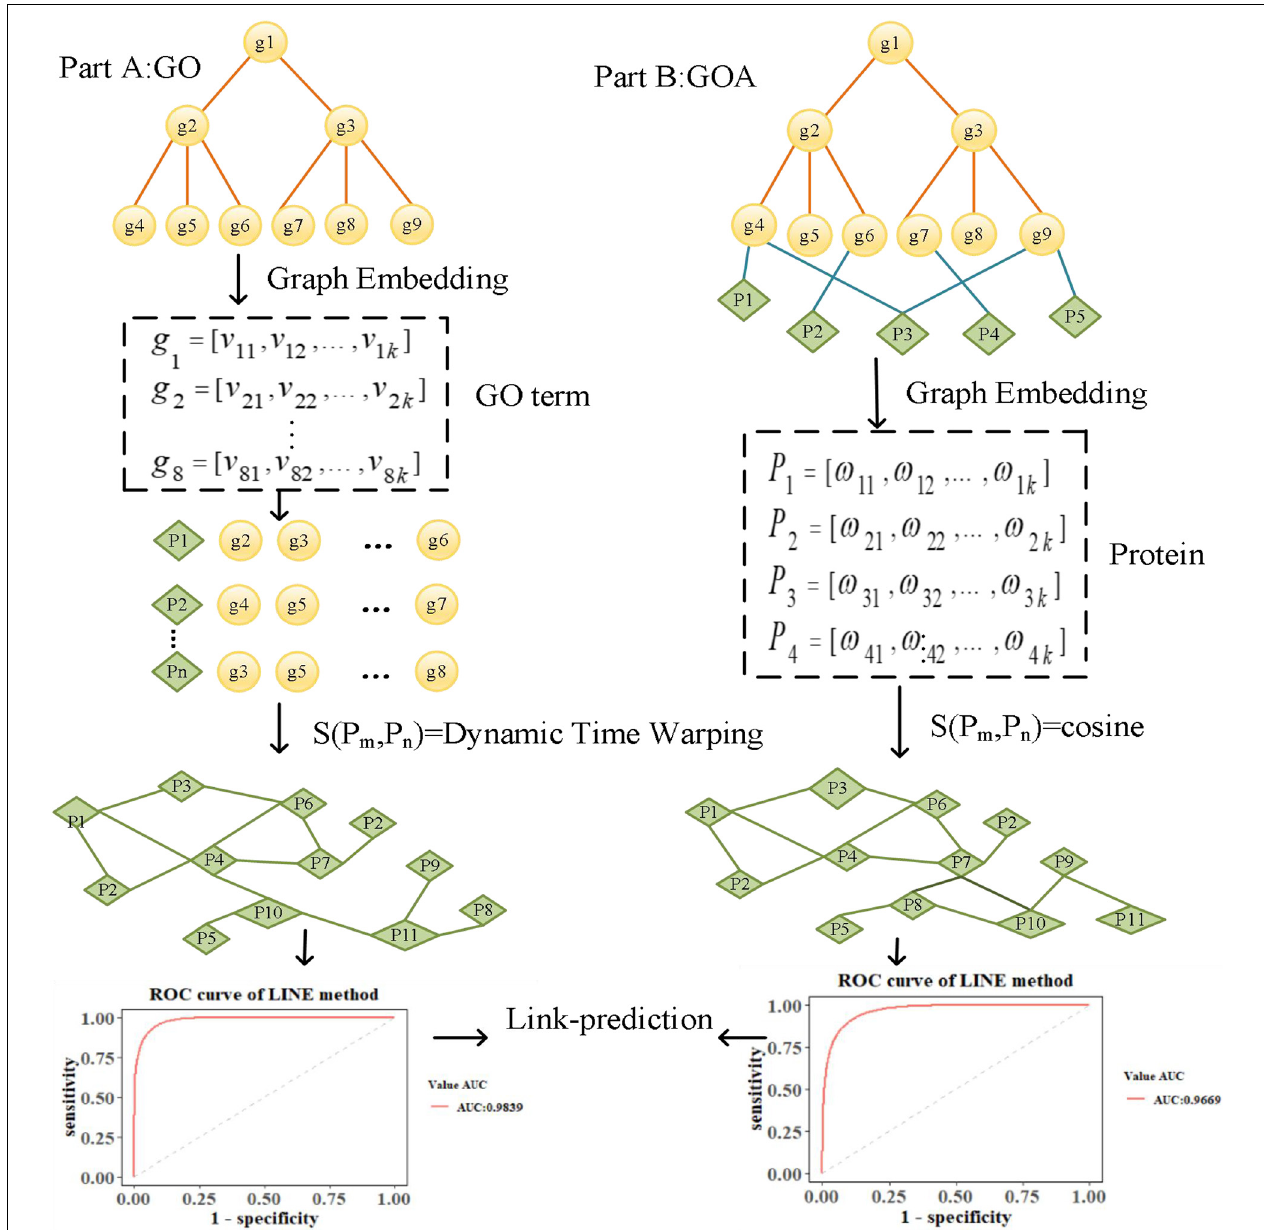
FIGURE 1 | Framework for analyzing protein